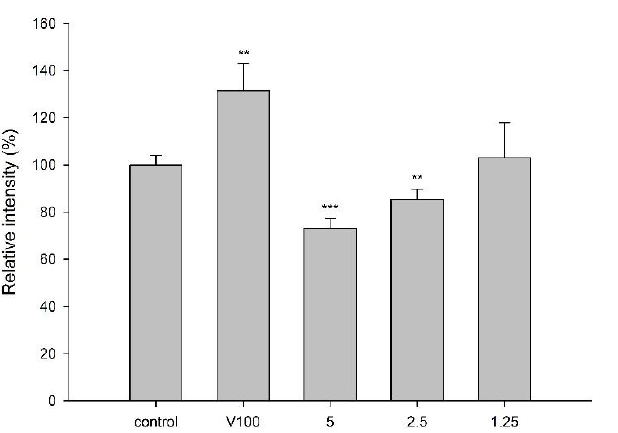
Figure 3. Effect of CJ (mg/mL) on the intracellular accumulation of R123 in LS 180 cells. V: verapamil (100 μM, positive control of P -gp inhibitor). ** p < 0.01 and *** p < 0.001.